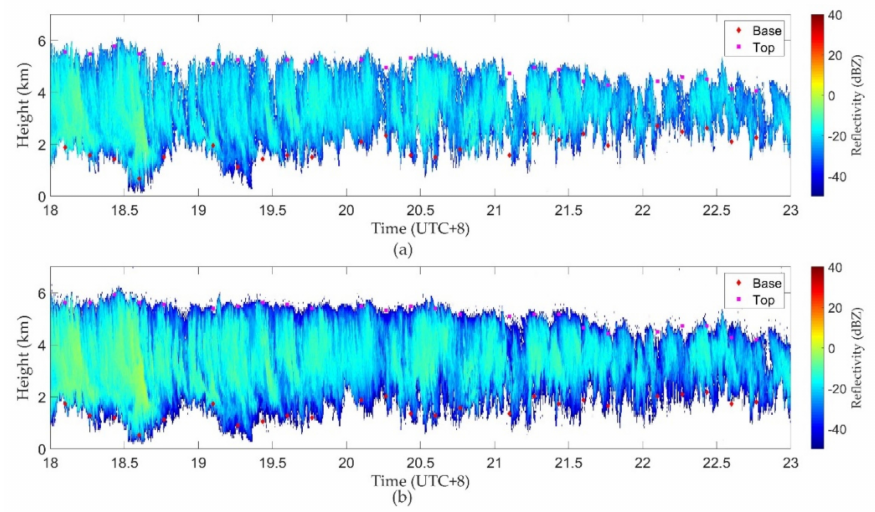
Figure 15. A case on 15 December 2019 showing the CTH (purple) and CBH (red) calculated at intervals of 10 min: ( a ) Ka-band radar; ( b ) W-band radar.